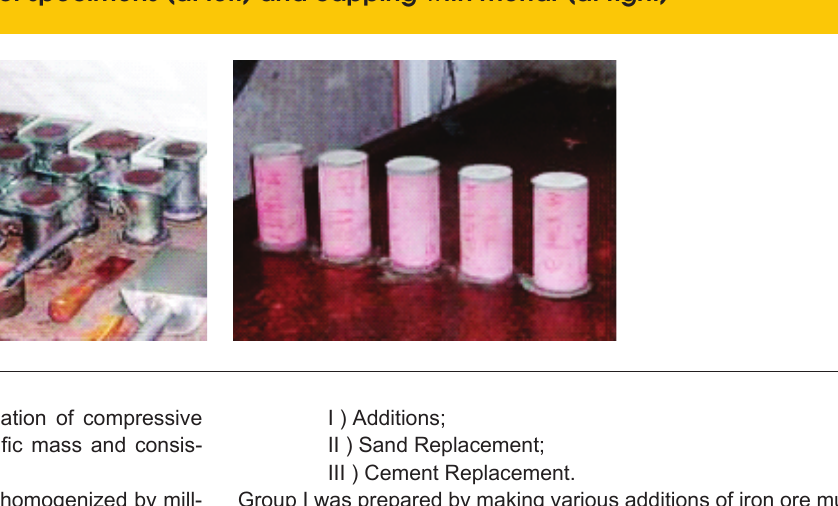
Figure 2 – Molding of specimens (at left) and capping with mortar (at right)